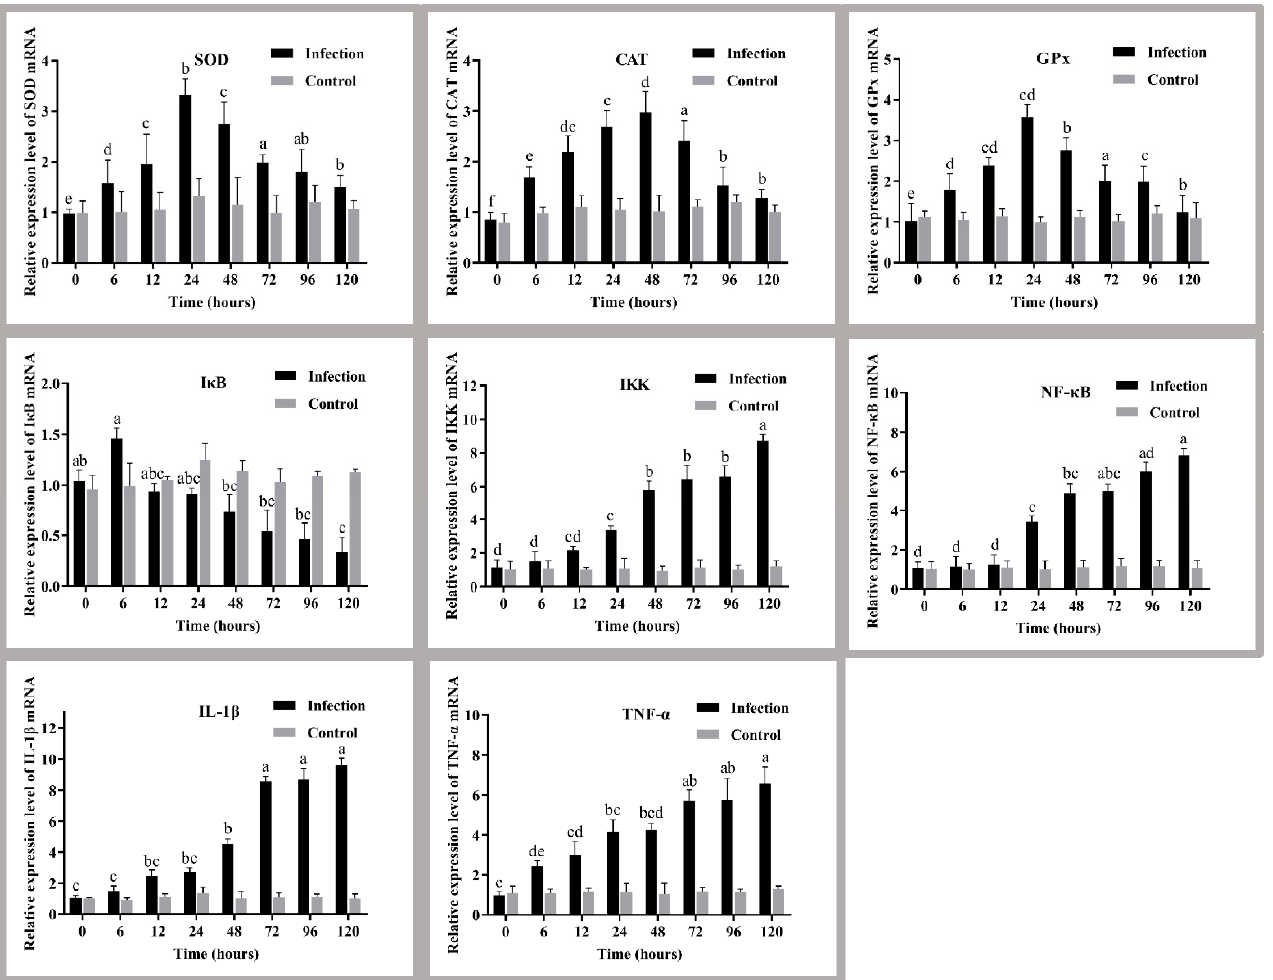
Figure 4. Liver antioxidant capacity and pathway genes of golden pompano before and after the challenge. Different letters indicate significant differences between the stress groups ( p < 0.05). The values are the means ± SEs ( n = 3). The grey bars represent the indicators of fish before the challenge, and the black bars represent indicators of fish after the challenge. IKK, inhibitor of kappa-B kinase; IKB , NF-kappa-B inhibitor; NF- κ B, nuclear factor kappa-B; TNF- α , tumour necrosis factor α ; IL-1 β , interleukin 1 β .